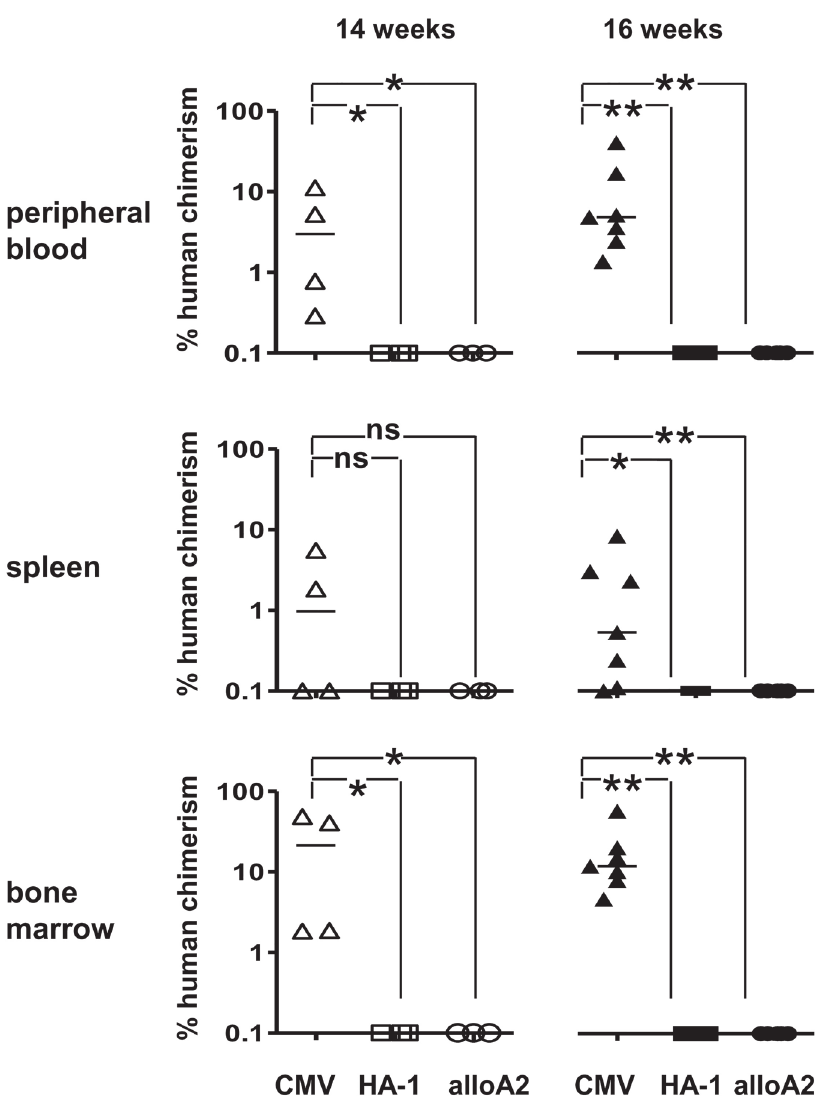
CMV CTL clone (triangles), HA-1 CTL clone (boxes) or anti-HLA-A2 CTL clone (circles) and transplanted into sublethally irradiated NOD/SCID mice. After 14 – 16 weeks, mice were sacrificed. Depicted is the % human hematopoietic chimerism in the peripheral blood, spleen and bone marrow of the individual mice after 14 (white symbols; n = 4 mice per group) and 16 (black symbols; n = 3 – 4 mice per group and donor) weeks in three independent experiments. The bar represents the mean of the group. Results from unpaired Mann- Whitney U statistical analyses are shown ( * p < 0,05; ** p < 0,01; ns = not significant).